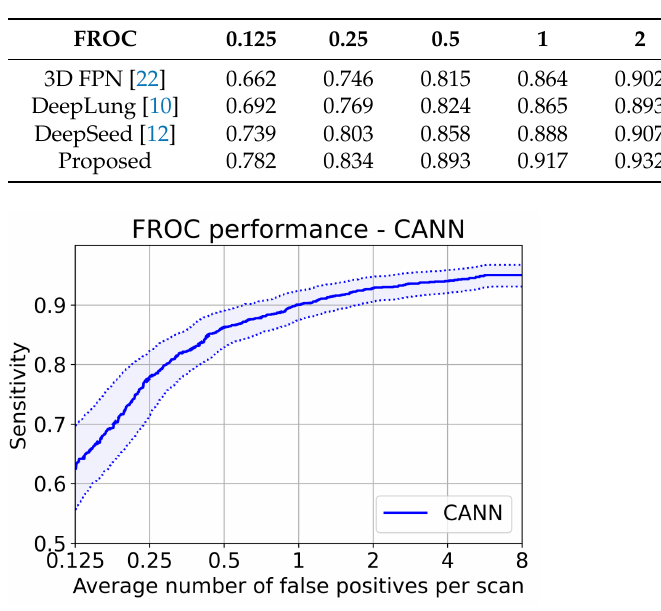
Table 2. FROC of different numbers of false positives per scan per exam on LUNA16.